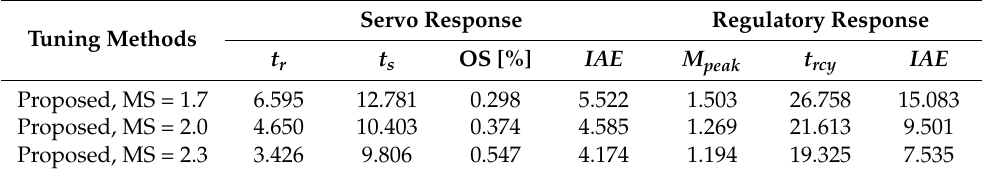
Figure 11. Unit step responses according to MS for nominal process 𝑃 2 . Table 12. Performance comparisons for nominal process 𝑃 2 according to MS.